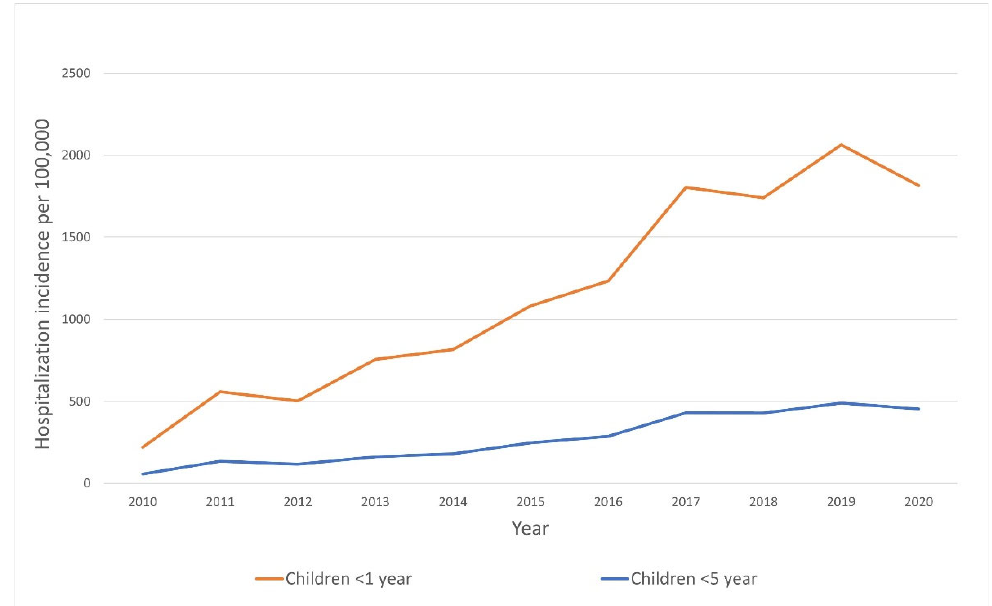
Figure 4 . Hospitalization rate trends due to RSV infection in Poland, 2010 – 2020.